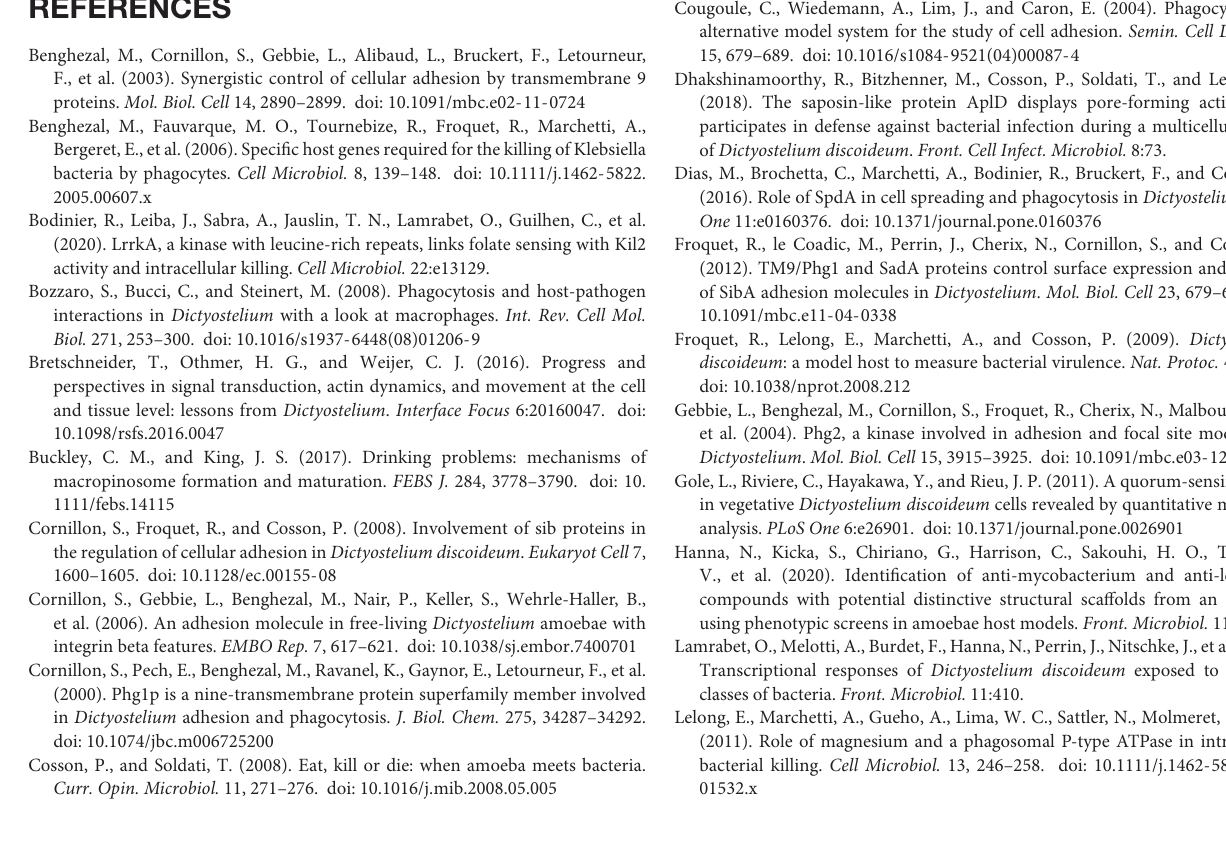
cells in fresh medium in the same experiment (average ± SEM, N = 3 independent experiments). Cells incubated in fresh medium (0% cell supernatant) phagocytosed beads approximately four times more efficiently than cells incubated in pure cell supernatants (100% cell supernatant) containing concentrated quorum-sensing factors. Cell supernatants diluted with fresh medium were also assessed to evaluate more precisely the quorum-sensing activity. The supernatant of lrrkA KO cells exhibited exactly the same inhibitory effect on phagocytosis as the supernatant of WT cells. Supplementary Figure S3 | GFP-LrrkA is localized in the nucleus and the cytosol. LrrkA KO cells expressing GFP-LrrkA were fixed with 2% formaldehyde and visualized by confocal microscopy. GFP fluorescence was visible in the nucleus (arrowheads) and in the cytosol. Untransfected lrrkA KO cells were used in parallel as negative controls and did not show any GFP fluorescence. Bar: 5 µ m. Supplementary Figure S4 | Cellular levels of SibA, PDI, and Talin A are similar in WT and lrrkA KO cells. (A) Cellular proteins were separated on an SDS-polyacrylamide gel, transferred to nitrocellulose, and the indicated proteins were detected with specific antibodies. (B) The intensity of the signal was determined in several independent experiments, and is indicated as a ratio of the signal in lrrkA KO and WT cells. The quantification of the experiment shown in A is indicated in red. The amount of SibA, Talin, and PDI (used as a control) was indistinguishable in lrrkA KO and WT cells. Supplementary Figure S5 | Regulation of gene expression by folate. D. discoideum WT cells grown in HL5 were exposed or not to 1 mM folate for 4 h. RNA-seq analysis allowed the identification of 10 genes for which transcription was significantly altered by exposure to folate. (A) For each gene considered ( fol1 to fol10 ), the gene identity and name are indicated, as well as the pair of primers used for RT-PCR and the size of the amplicon. (B) For the 10 genes analyzed, RT-PCR analysis confirmed the results obtained by